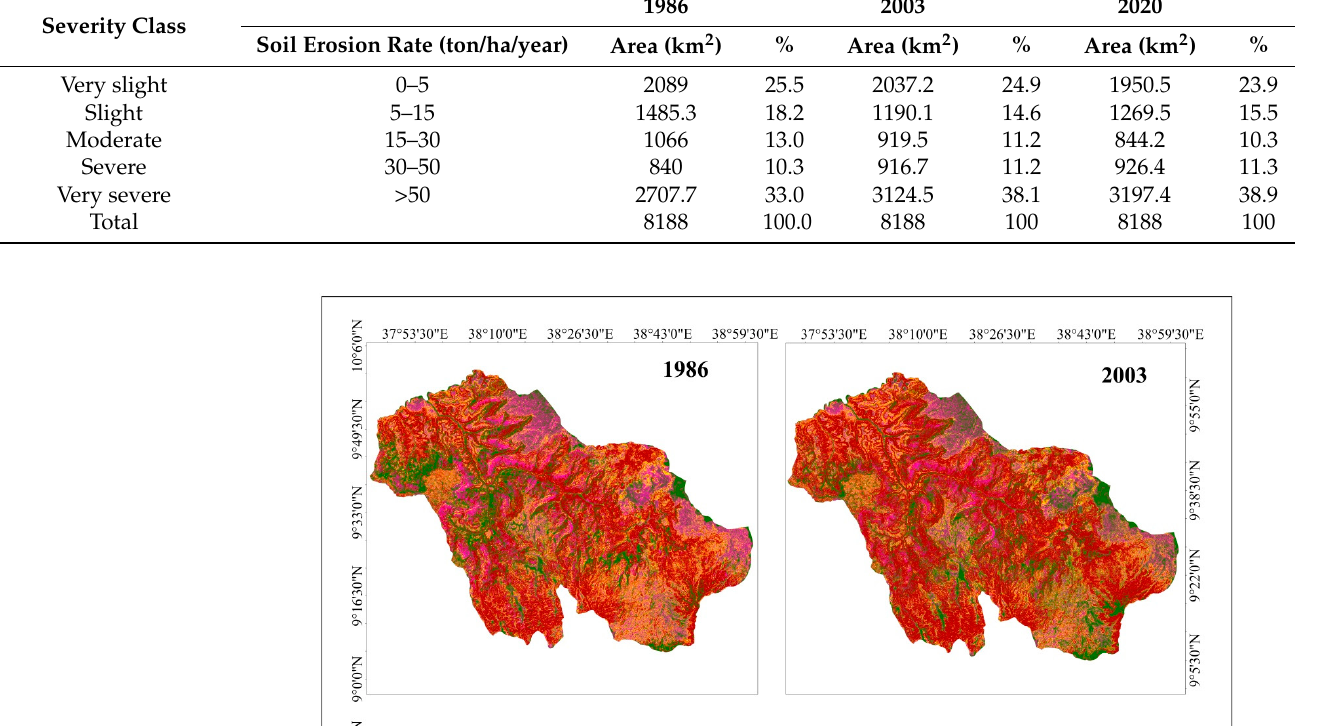
Table 8. Mean soil loss rate across different LULC classes in the Muger Sub-basin.